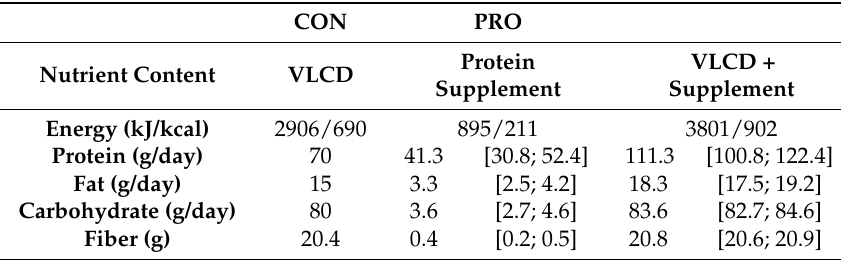
Table 1. Very low caloric diet (VLCD) and protein